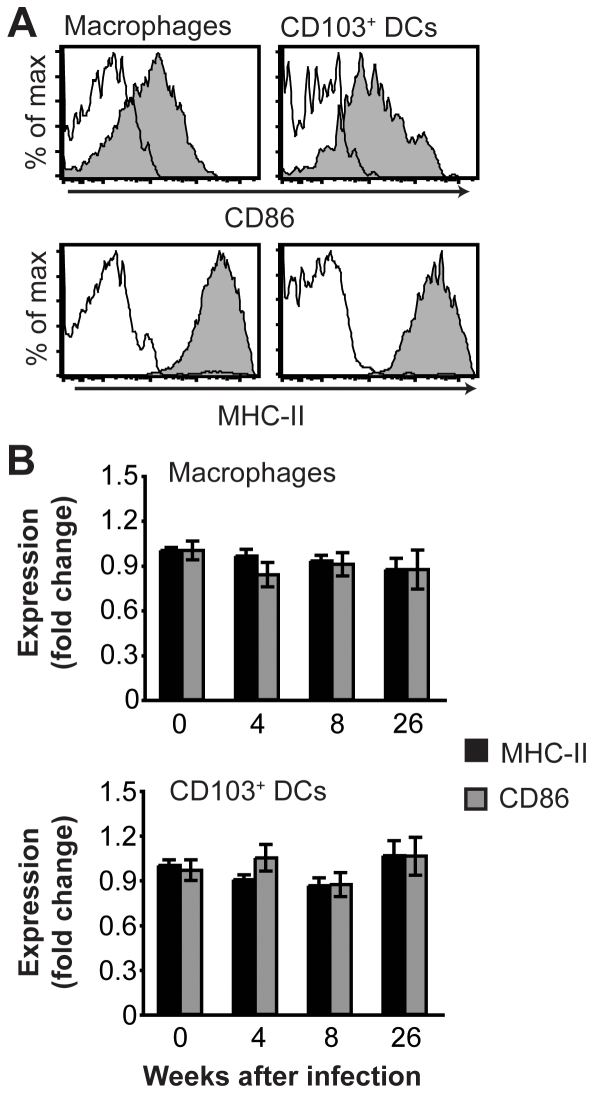
Expression of CD86 and MHC-II by gastric macrophages and DCs.(A) Filled histograms show expression of CD86 and MHC-II by gastric macrophages (Gr1−CD11b+CD103−Siglec-F−MHC-II+) and CD103+ DCs (CD11c+CD103+) from a naïve mouse. Open histograms show staining with isotype controls. (B) Expression of CD86 and MHC-II by gastric macrophages and CD103+ DCs at the indicated time points after H. pylori infection as determined by flow cytometry. The geometric mean fluorescence intensity of CD86 and MHC-II was normalized to the level in age-matched uninfected mice. Data represent mean ± SEM of 10–16 individual mice.